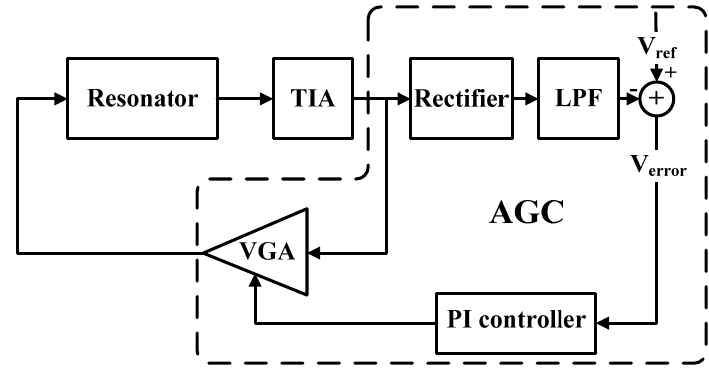
Figure 1. AGC-PI based velocity-controlled closed-loop for the drive mode of MEMS vibratory